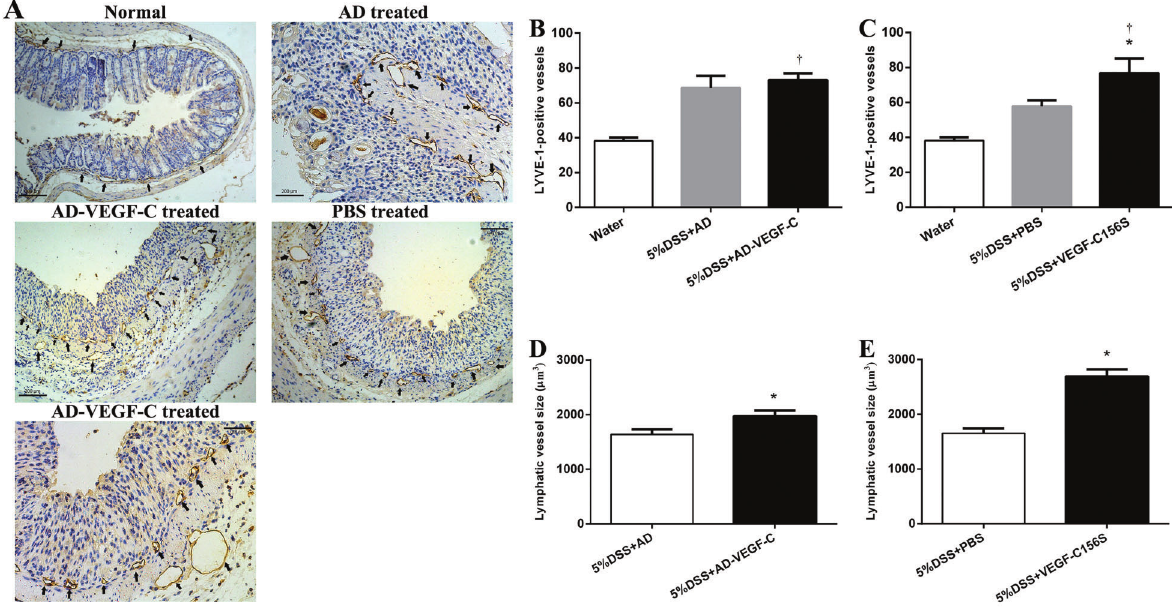
Figure 3. Immunohistochemical results for lymphatic remodeling in acute colitis ( A ). Comparison of lymphatic vessel density (LVD) between AD-VEGF-C treated and control mice ( B ) and between AD-VEGF-C156S-treated and control mice ( C ). AD-VEGF-C did not induce an increase in LVD (P=0.50), whereas VEGF-C156S induced a 1.3-fold increase in LVD compared to PBS-treated mice. Comparisons of lymphatic vessel size between AD-VEGF-C-treated and DSS-treated mice are shown in panel D and between AD-VEGF-C156S-treated and PBS-treated mice are shown in panel E . Both AD-VEGF-C and VEGF-C156S-treated mice had signi fi cantly greater lymphatic vessel size compared to control mice (both P o 0.001). Data are reported as means ± SD (n=5/group). *P o 0.05 compared to DSS-treated group. w P o 0.05 compared to water-treated group. Statistical analysis was performed by ANOVA and Bonferroni ’ s post-hoc test for lymphatic vessel density and two-sample t -test for lymphatic vessel size. AD: adenovirus; PBS: phosphate-buffered saline; AD-VEGF-C: adenovirus vascular endothelial growth factor-C; DSS: dextran sodium mice (42.0 ± 1.4 vs 3.5 ± 0.4, P o 0.001) as well as control